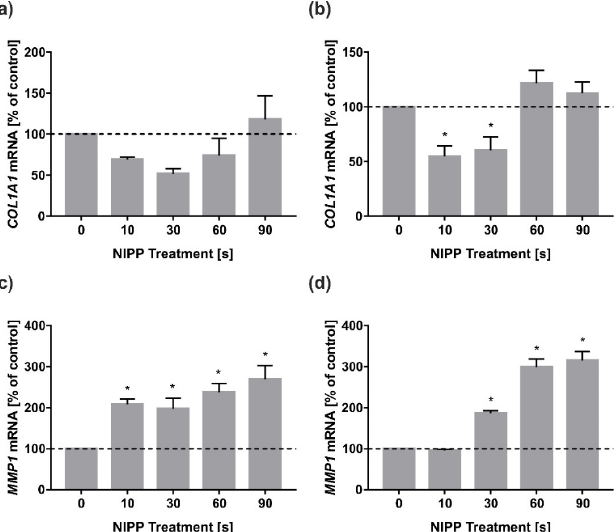
Figure 3. Impact of NIPP on COL1A1 and MMP1 mRNA levels in HGF and HGK at 24 h. Treatment was performed for the indicated times: ( a ) COL1A1 mRNA in HGF; ( b ) COL1A1 mRNA in HGK; ( c ) MMP1 mRNA in HGF; ( d ) MMP1 mRNA in HGK. n = 9. * statistical significance compared to control (0 s) ( p < 0.05).